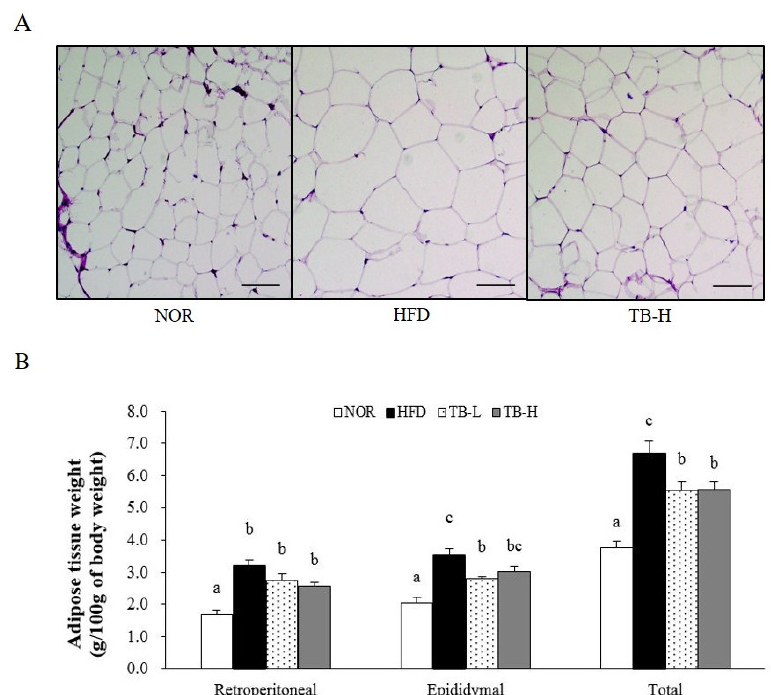
Figure 1. Effects of tartary buckwheat extract on white adipose tissue weight and adipocyte size. ( A ) Histology of adipose tissue. Representative images of hematoxylin and eosin (H&E) staining. Scale bars = 50 μm. ( B ) White adipose tissue weight. Data are expressed as mean ± SEM ( n = 8). Values with different letters are significantly different at p < 0.05. NOR: normal diet; HFD: 45% high-fat diet; TB-L: HFD + 0.5% TB; TB-H: HFD + 1.0% TB.